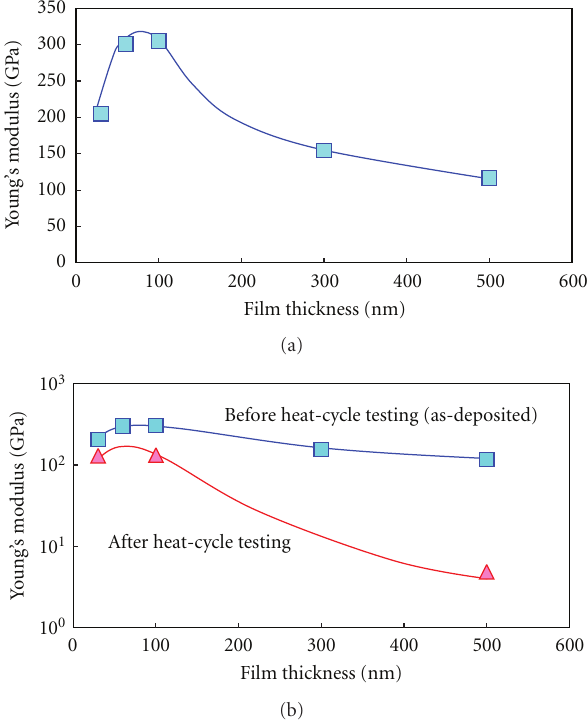
Figure 10: Young’s modulus in the in-plane direction ( a -axis of Wurtzite cell) of the GZO film formed by the RPD system as a function of film thickness. (a) Young’s modulus before heat-cycle testing (as-deposited). (b) Reduction in Young’s modulus value of the thin film caused by the heat-cycle testing. The same data in (a) is redrawn in